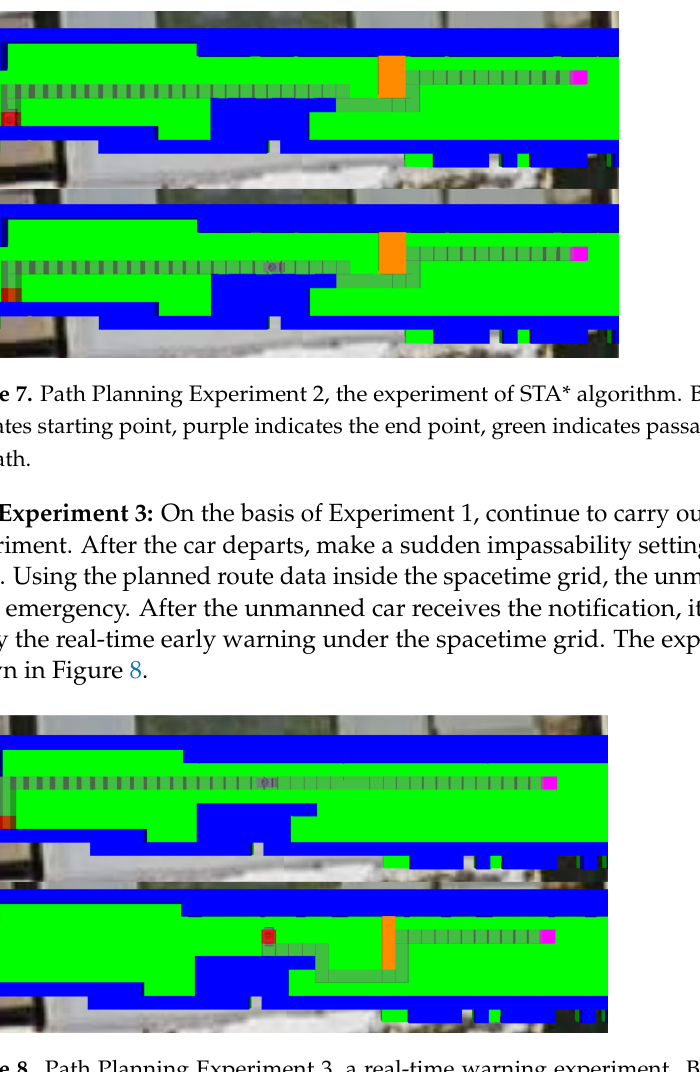
Figure 6. Path Planning Experiment 1, ordinary A* path planning. Blue indicates wall, red indicates starting point, purple indicates the end point, green indicates passable area, grey indicates the path, orange indicates obstacles.